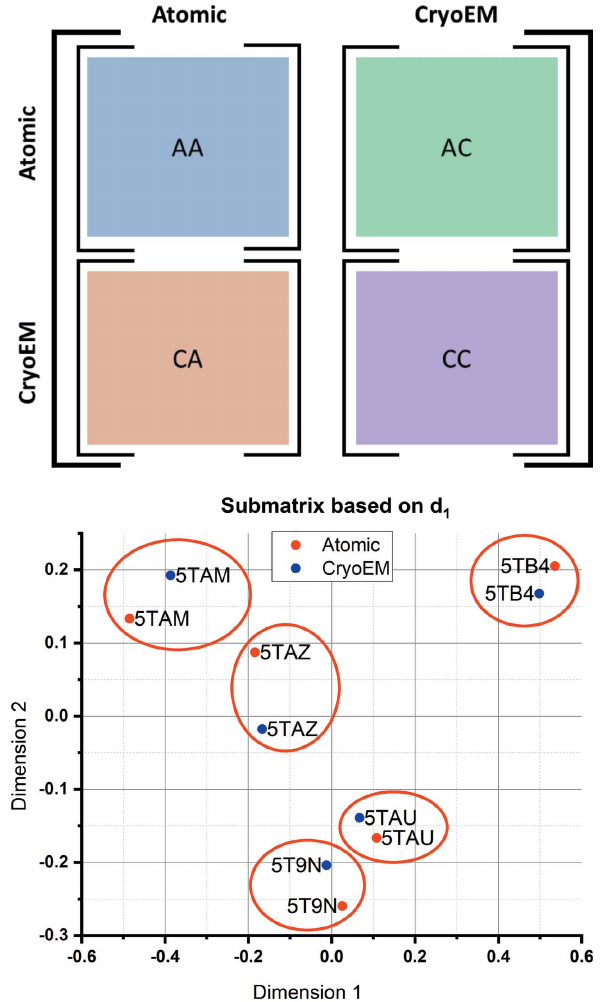
Figure 5 Results obtained after applying the Zernike3D algorithm to a set of cryo- EM maps from the ryanodine receptor 1 (RyR1) followed by a decomposition of the distance matrix computed by the algorithm into different blocks to recover more meaningful structure mappings. (Top) A partition of the distance matrix into 2 (cid:5) 2 blocks. Each block stores the distances obtained when comparing the different map types used in this test (pairs of experimental cryo-EM maps and maps derived from atomic structures representing the same conformational state): AA (atomic versus atomic), AC (atomic versus cryo-EM), CA (cryo-EM versus atomic) and CC (cryo-EM versus cryo-EM). (Bottom) A consensus structure map for pairs of RyR1 conformations (from atomic model- derived simulated maps and from cryo-EM maps) resulting from the analysis of the blocks. The red circles are used to enhance the visualization of the different pairs. When compared with Fig. 4( a ), it is possible to see that this decomposition of the distance matrix leads to a proper recovering of all the pairs found in the data set.